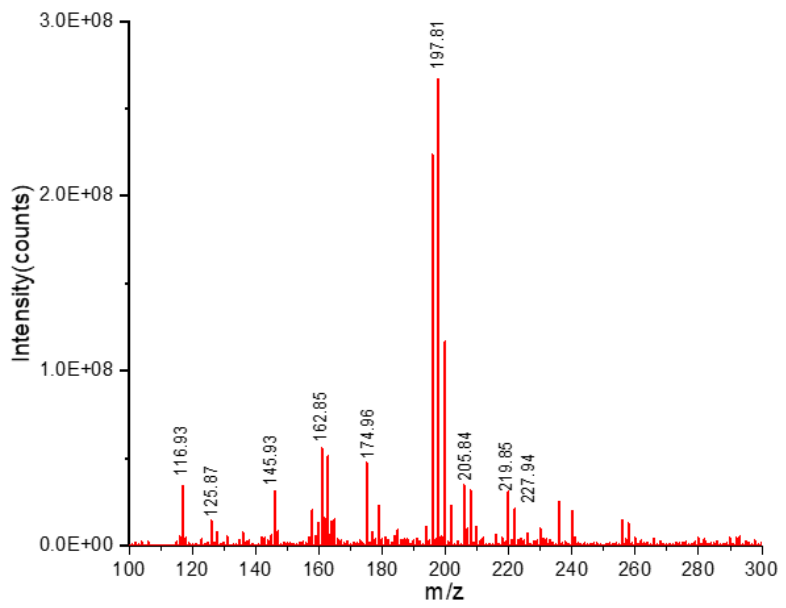
Figure 5. Mass spectrometry spectra of the extract of O. bataua